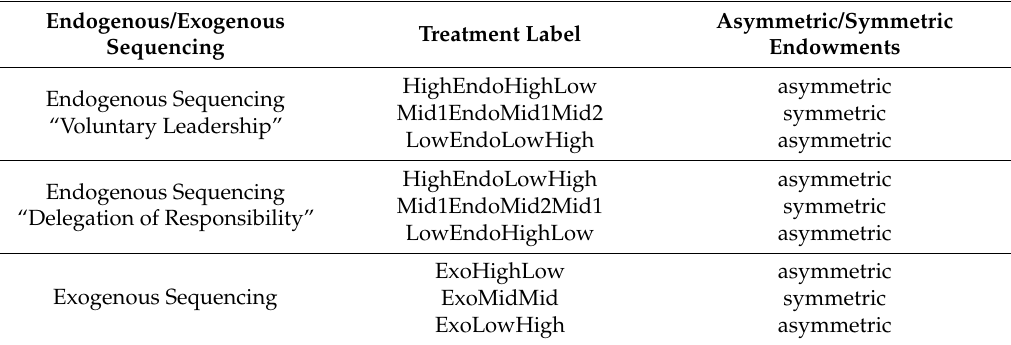
Table 1. Game Variants and Treatment